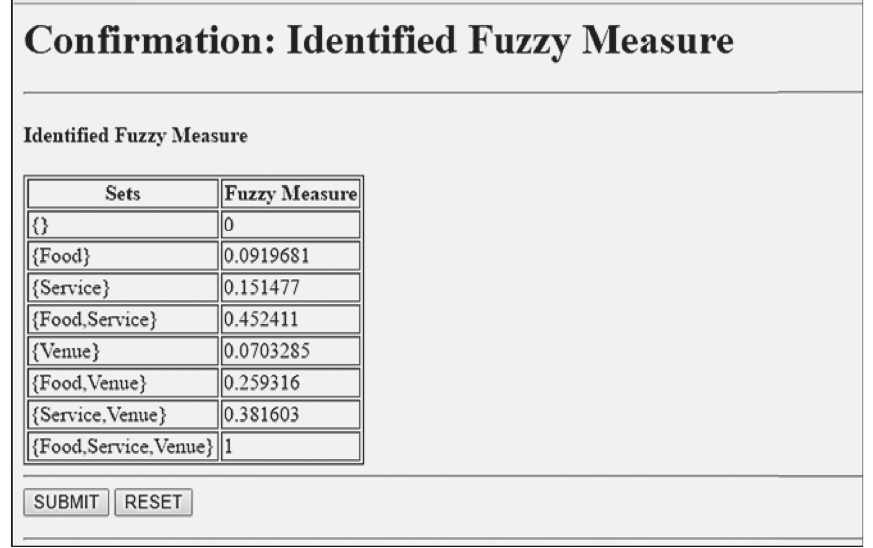
Figure 3: Fuzzy measure for each